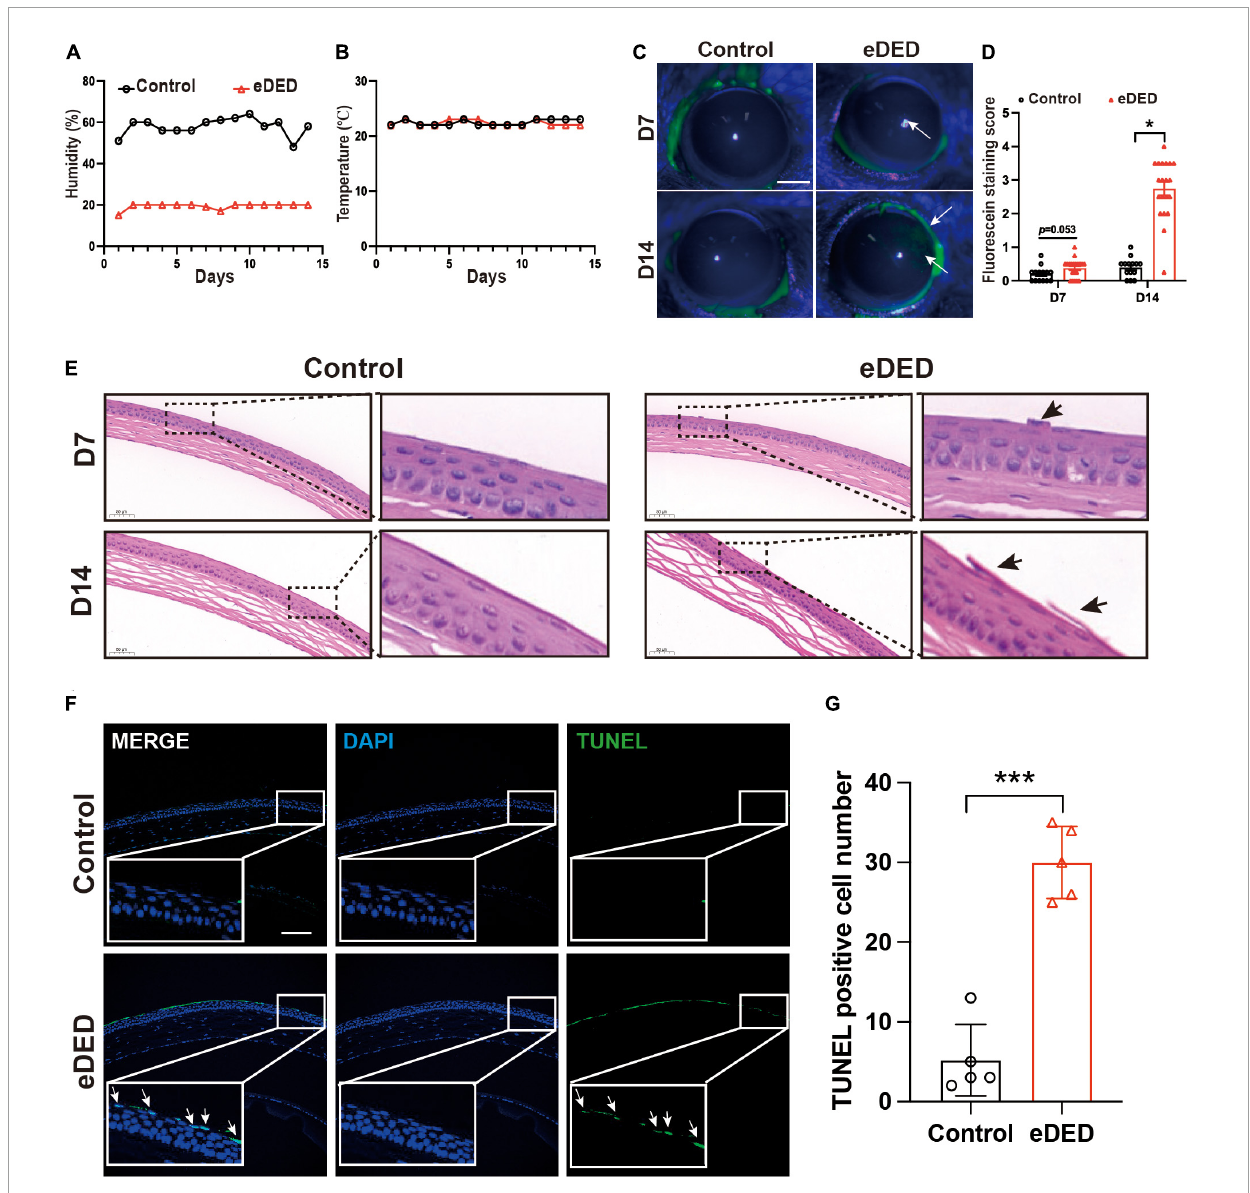
FIGURE1 Corneal epithelium injury in environmental dry eye disease mice. (A) Decreased mean relative humidity recordings in the CDS (20 ± 2%) compared to the vivarium (55 ± 5%) throughout the experiment. (B) Mean temperature (21 ± 1 ◦ C) recordings in the CDS and vivarium throughout the experiment. (C) Increased corneal epithelium defective area is indicated by corneal fluorescein sodium staining (green, arrows) was shown in eDED mice on day 7 and 14; scale bar: 1 mm. (D) The score of corneal fluorescein sodium staining in control ( n = 15) and eDED mice ( n = 17), groups on day 7 and 14. (E) Increased desquamation of apical corneal epithelial cells (arrows) shown by corneal HE staining in eDED mice on day 7 and 14; scale bar: 50 µ m. (F) Representative images of corneal epithelium showing an increase in apoptotic cells (arrows) in eDED mice via TUNEL assay on day 14. Co-localization of TUNEL (green, arrows) and DAPI (blue); scale bar: 100 µ m. (G) Quantification of TUNEL positive cells in corneal epithelium in the control and eDED group on day 14 ( n = 5 in each group); Y-axis represents TUNEL positive cell number. Each dot represents mean